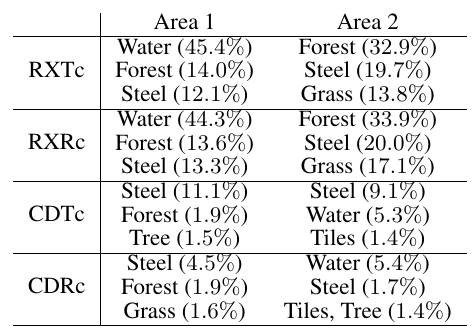
Table 3. Percentage of in-class anomalies for each class. definition of an anomaly as deviation from the expected, i.e. the simulation, is